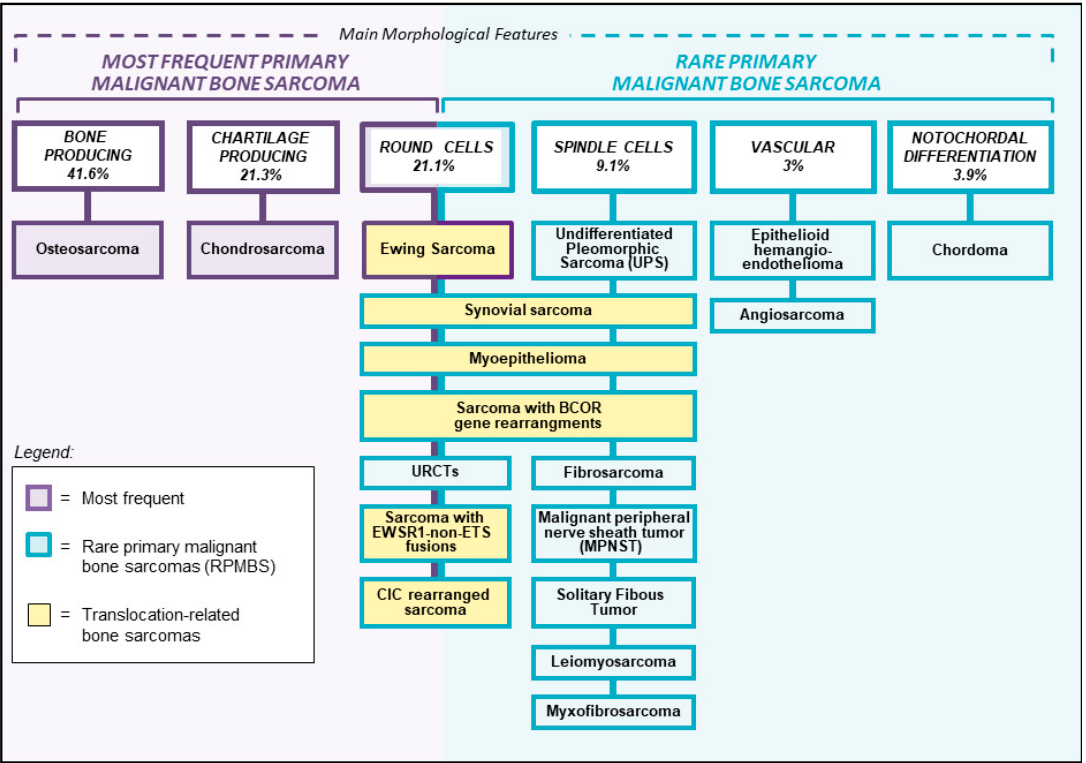
Figure 1. Diagnostic classification of rare primary malignant bone sarcoma. URCTs: undifferentiated round cells tumors; SFT: solitary fibrous tumor .